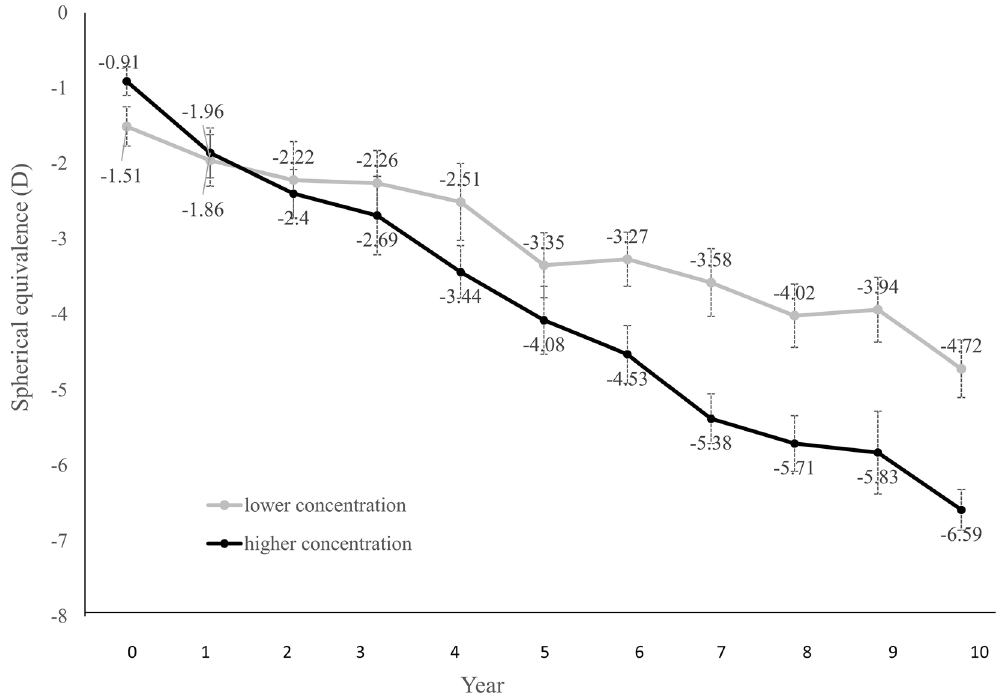
Figure 4. Spherical equivalence of stepwise lower concentration and stepwise higher concentration groups. D, diopter. Bars, standard error of the mean.